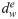
Results of the proposed MbD-LF-CPI method.Comparison of reconstructed results estimated with 15, 7, and 4 b-value DWIs in the first imaging slice of the brain. (a) extracellular volume fraction α, (b) extracellular mean diffusivity dwe, (c) intracellular diffusivity dwi, and (d) low-frequency mean conductivity σL. The 4-th and 5-th columns show the absolute values of difference between the results using 15 b-value DWIs with the results using 7 and 4 b-value DWIs, respectively.